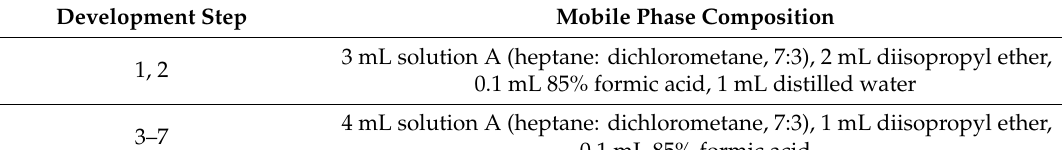
Figure 7. Chromatogram of the separation of flavonoids in methanol extract from L. album subsp. album flowers with the multiple gradient development technique (MGD). The bands of the standards correspond with the bands of the compounds in the extract: 1—rutoside; 2—isoquercetin; 3—quercetin; A—ethyl acetate extract-excluded from the investigations; B—methanol extract. Visible light, derivatization with the use of a 1% methanolic solution of aluminum chloride. The mobile phase elution program is given in Table 2. Chromatographic plate HPTLC Si 60 F 254. Table 3. Multiple gradient development program in the analysis of phenolic acids.